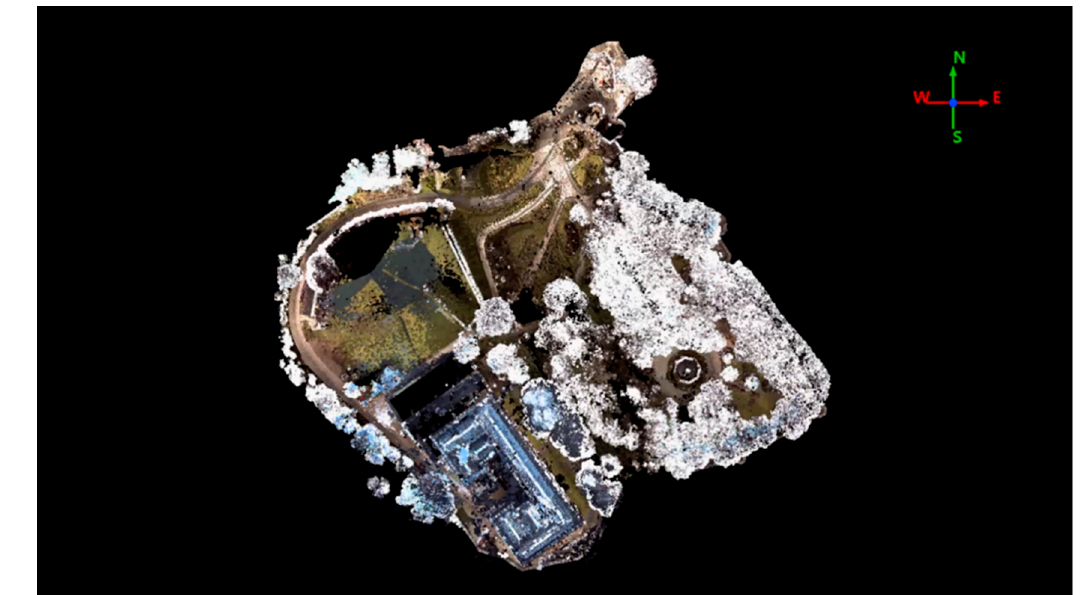
Remote Sens. 2021 , 13 , x FOR PEER REVIEW Figure 3. Plan view of Nottingham Castle and grounds, Nottingham. Figure 3. Plan view of Nottingham Castle and grounds, Nottingham.